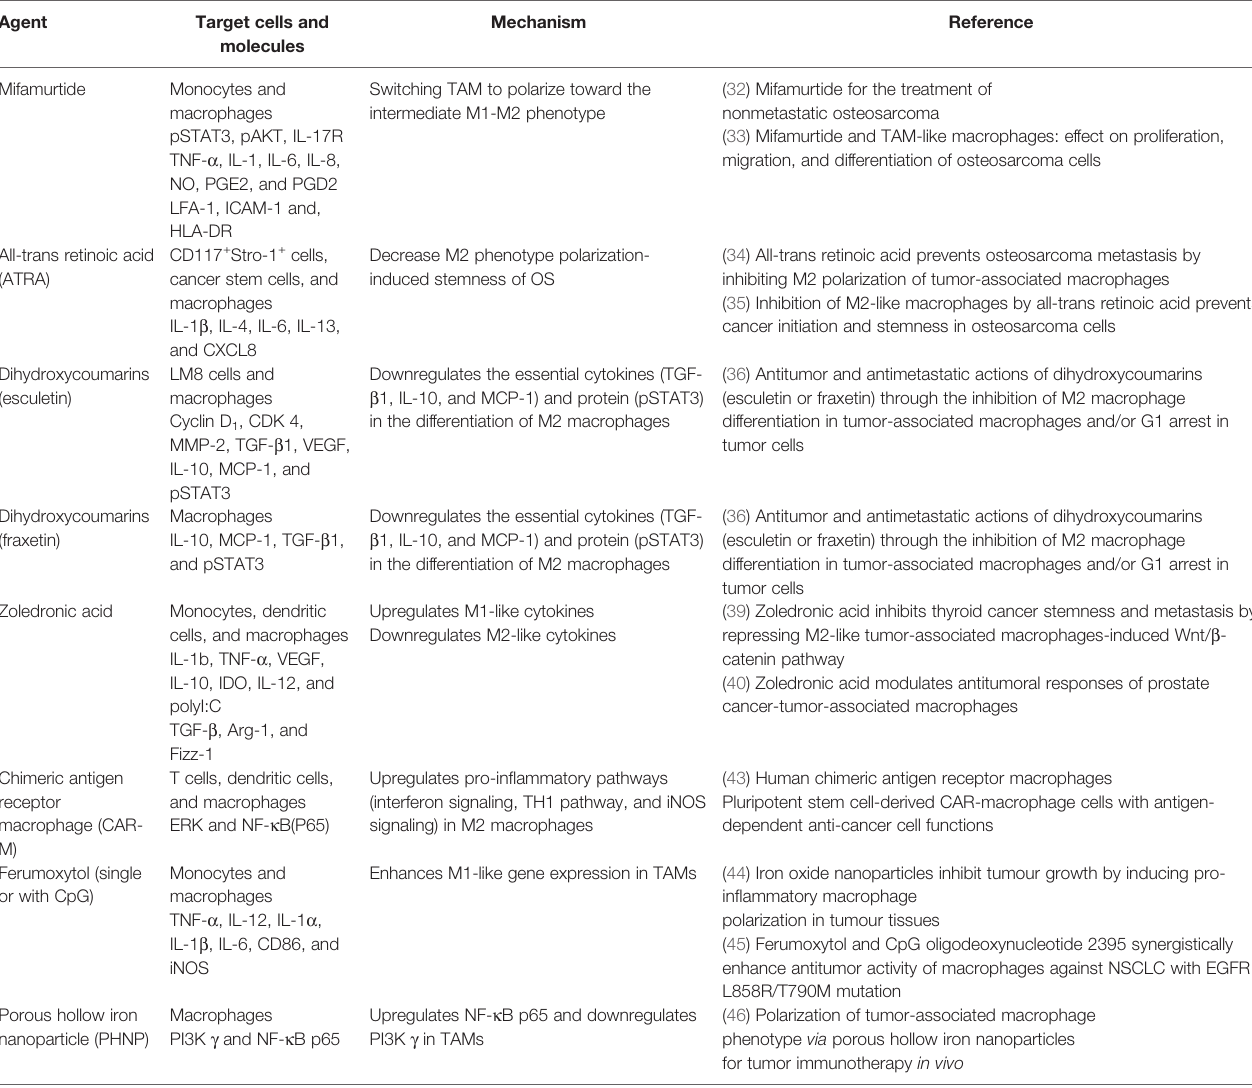
TABLE 1 | Therapeutic TAM targeting agents in OS. Agent Target cells and